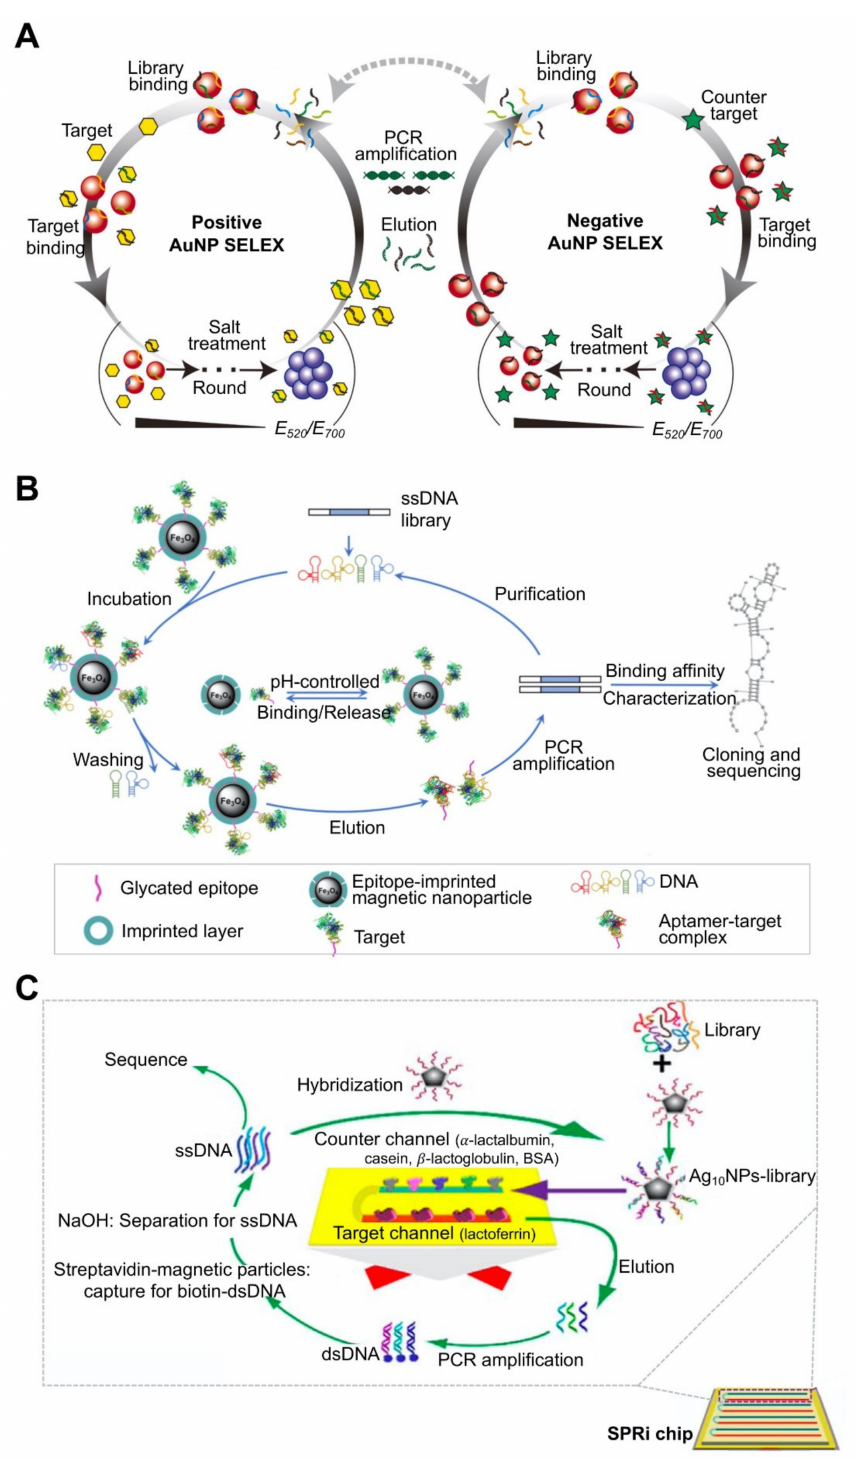
Figure 3. Aptamer discovery strategy using other nanomaterial–based platforms: ( A ) Brassinolide and bisphenol A-specific aptamers selection using a gold nanoparticle (AuNP) platform. Reproduced with permission from [74]. ( B ) Myoglobin and β 2-microglobulin-specific aptamers selection using an epitope-imprinted magnetic nanoparticle platform. Reproduced with permission from [78]; ( C ) Lactoferrin-specific aptamer selection using a silver decahedral nanoparticle (Ag 10 NPs)-based surface plasmon resonance imaging (SPRi) platform. Reproduced with permission from